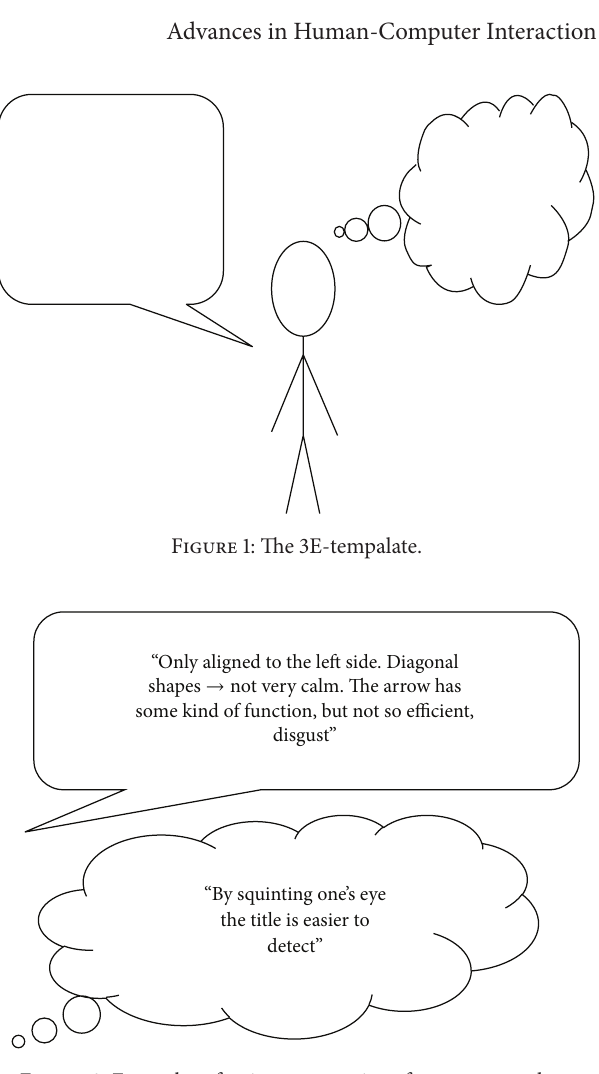
Figure 2: Examples of written expressions from one